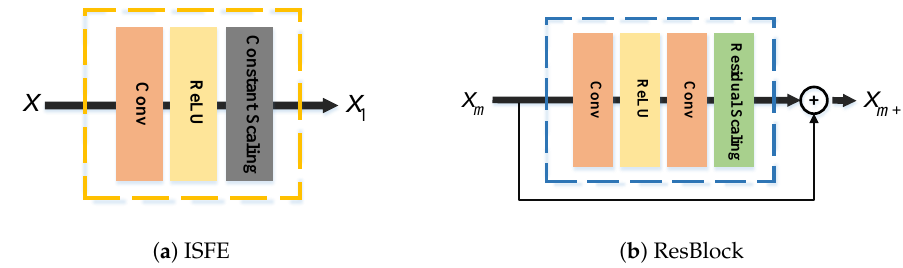
Figure 2. Expanded view of the ISFE and ResBlock. ( a ) ISFE; ( b )